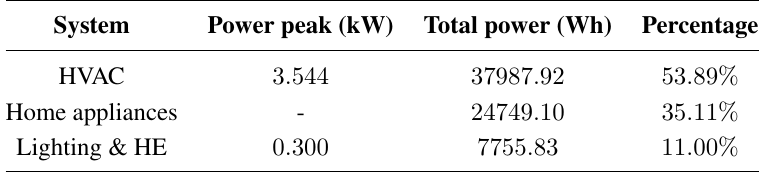
Table 1. Energy consumption per subsystem. HVAC: heating, ventilation and air conditioning; HE: home